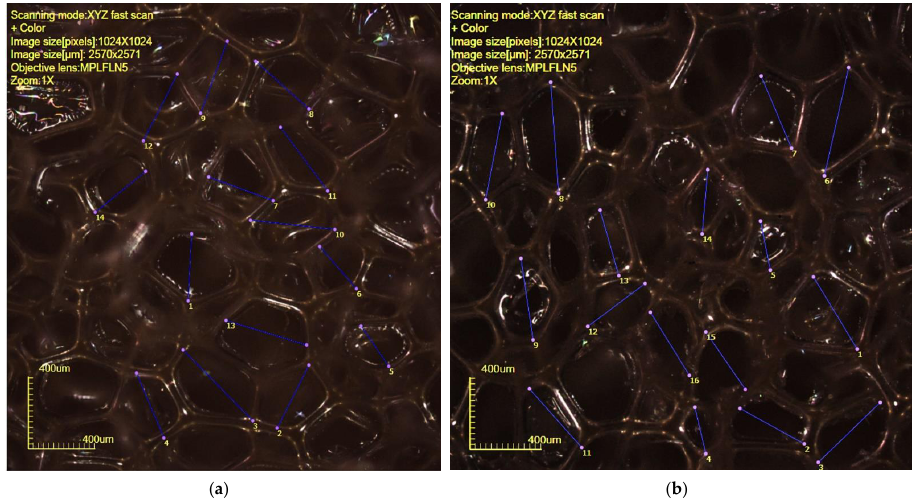
Figure 3. Pore topography for the two polyurethane sponges that were used as sacrificial templates obtained with confocal microscopy: ( a ) green (G) and ( b ) blue (B).